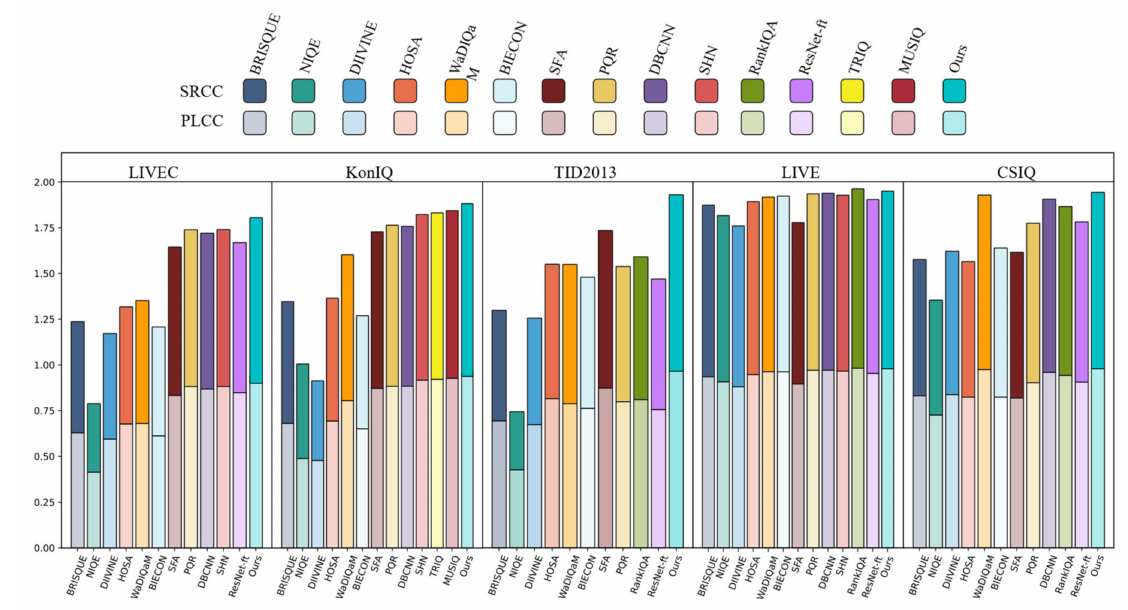
Figure 10. Histogram representation of the data in Table